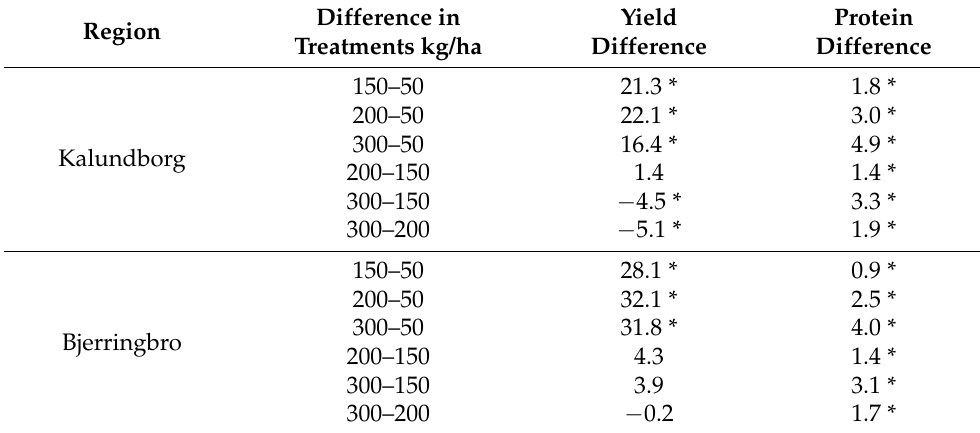
Table 3. Mean differences between the treatments for yield and protein contents in both experimental regions (* significant differences with p -value ≤ 0.05). Difference in Yield Protein Region Treatments kg/ha Difference Difference